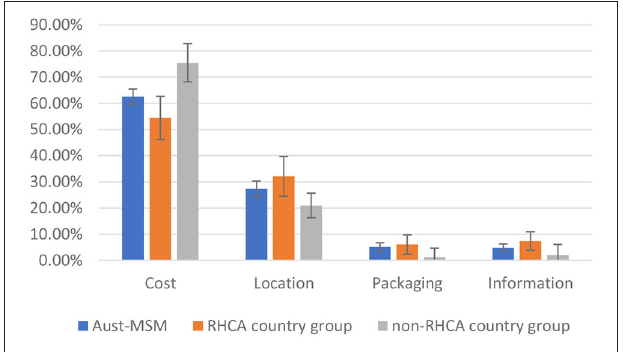
FIGURE 2 | Relative importance of HIV-self testing distribution attributes among Aust-MSM, RHCA-eligible group, and RHCA-ineligible